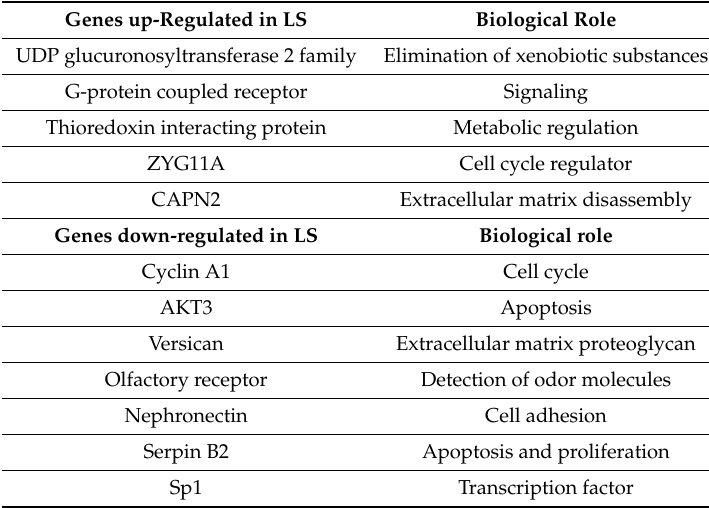
Table 2. Di ff erentially-regulated genes in Laron syndrome. Bioinformatic analyses identified sets of over- and under-represed genes in LS-derived lymphoblastoid cells that might underlie cancer protection in this